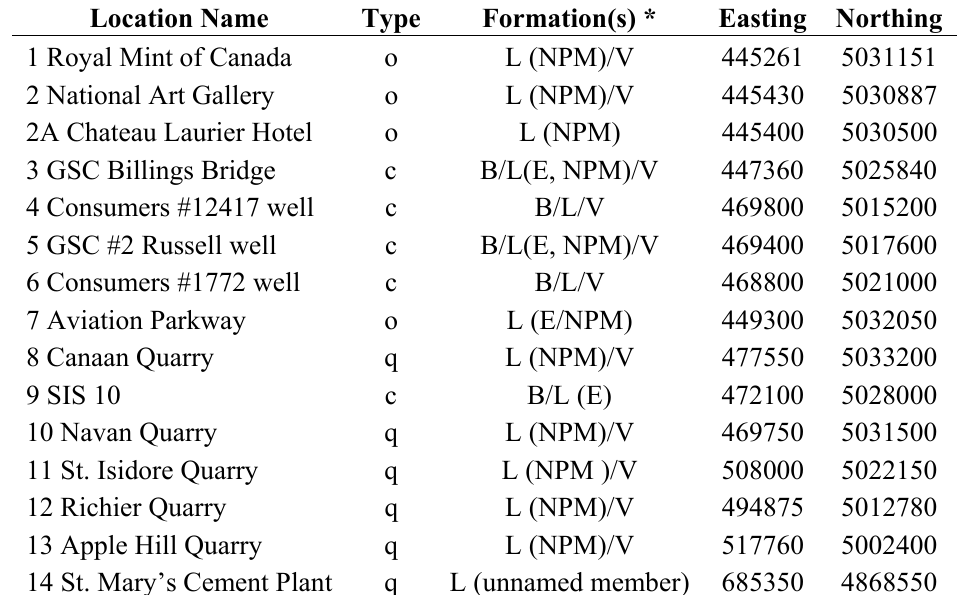
Table 1. Section localities, type (o, outcrop; c, core; q, quarry), and lithic succession. NTS easting and northing data (meters) from map sheet: Ottawa 31G, grid zone